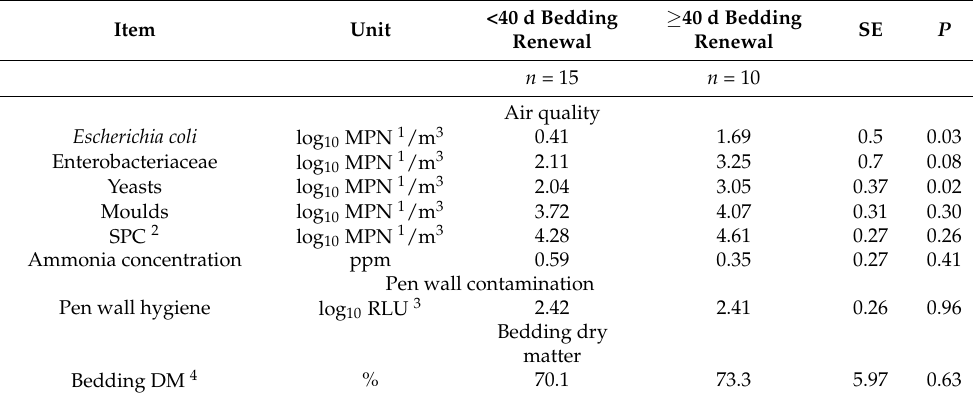
Table 5. Effect of interval between bedding renewals on air quality, contamination of pen walls and humidity of bedding material.